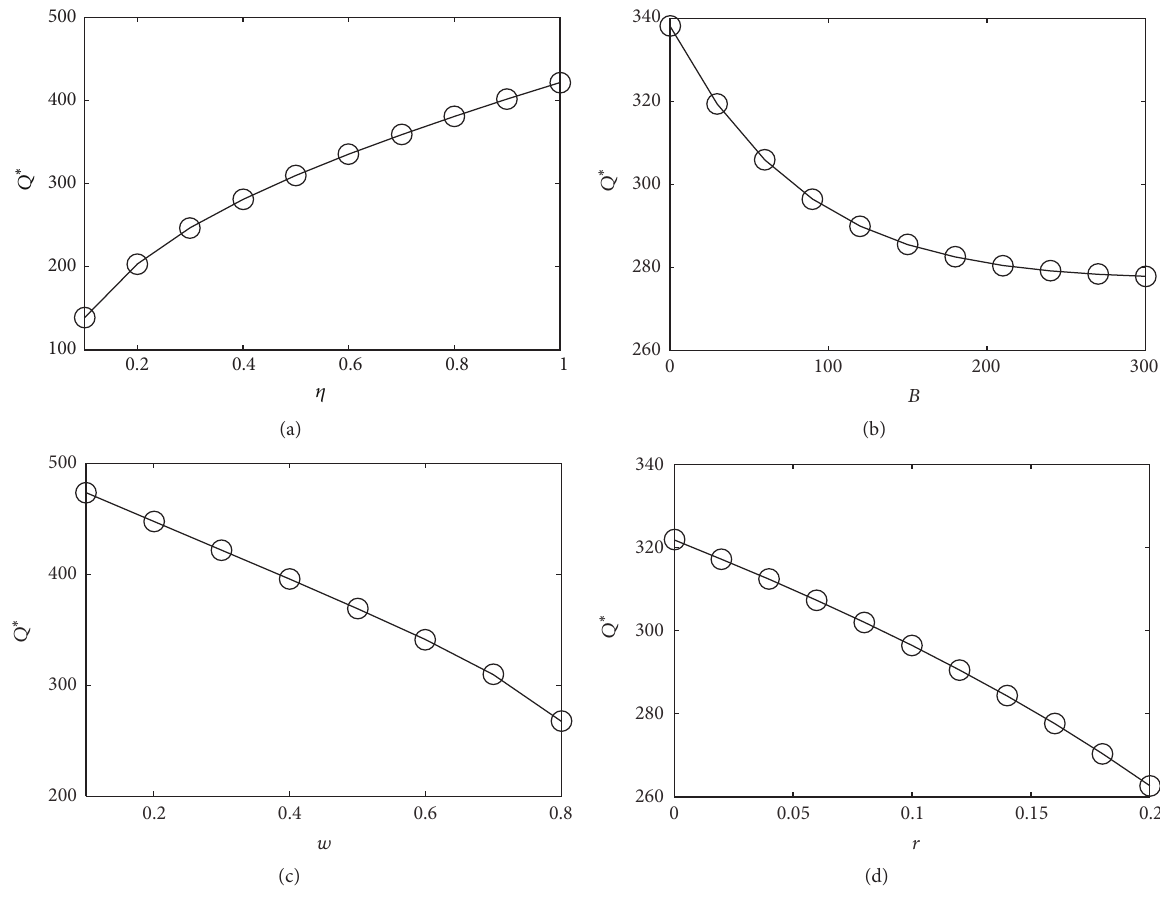
Figure 1: Impact of 𝜂 , 𝐵 , 𝑤 , and 𝑟 on retailer’s order